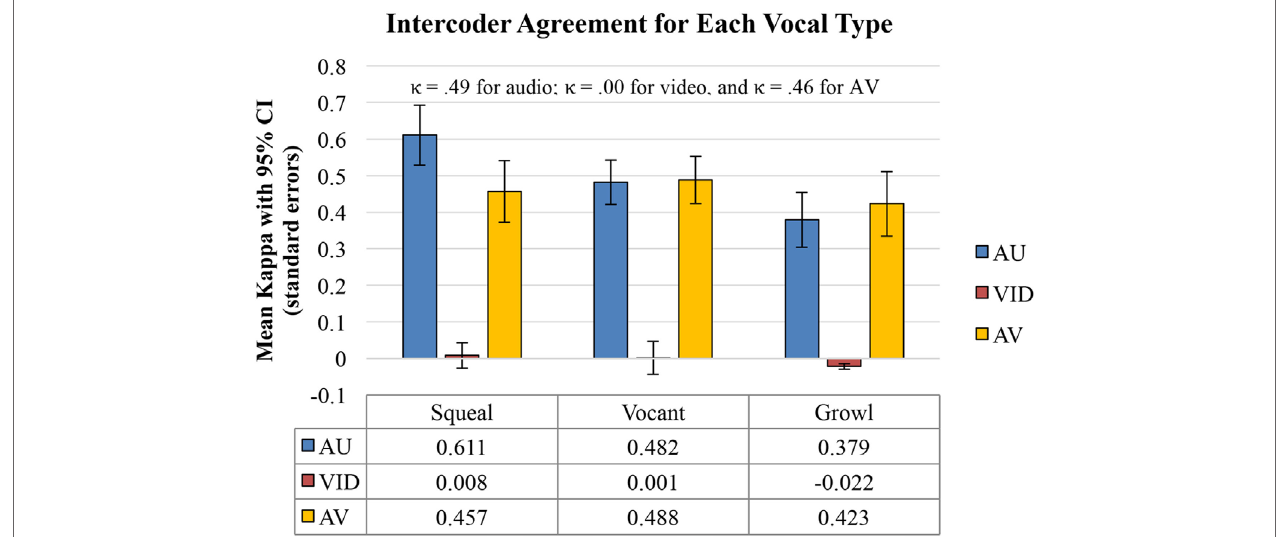
information on all three vocal types. 95% confidence intervals are included. Kappas at the top of the figure are